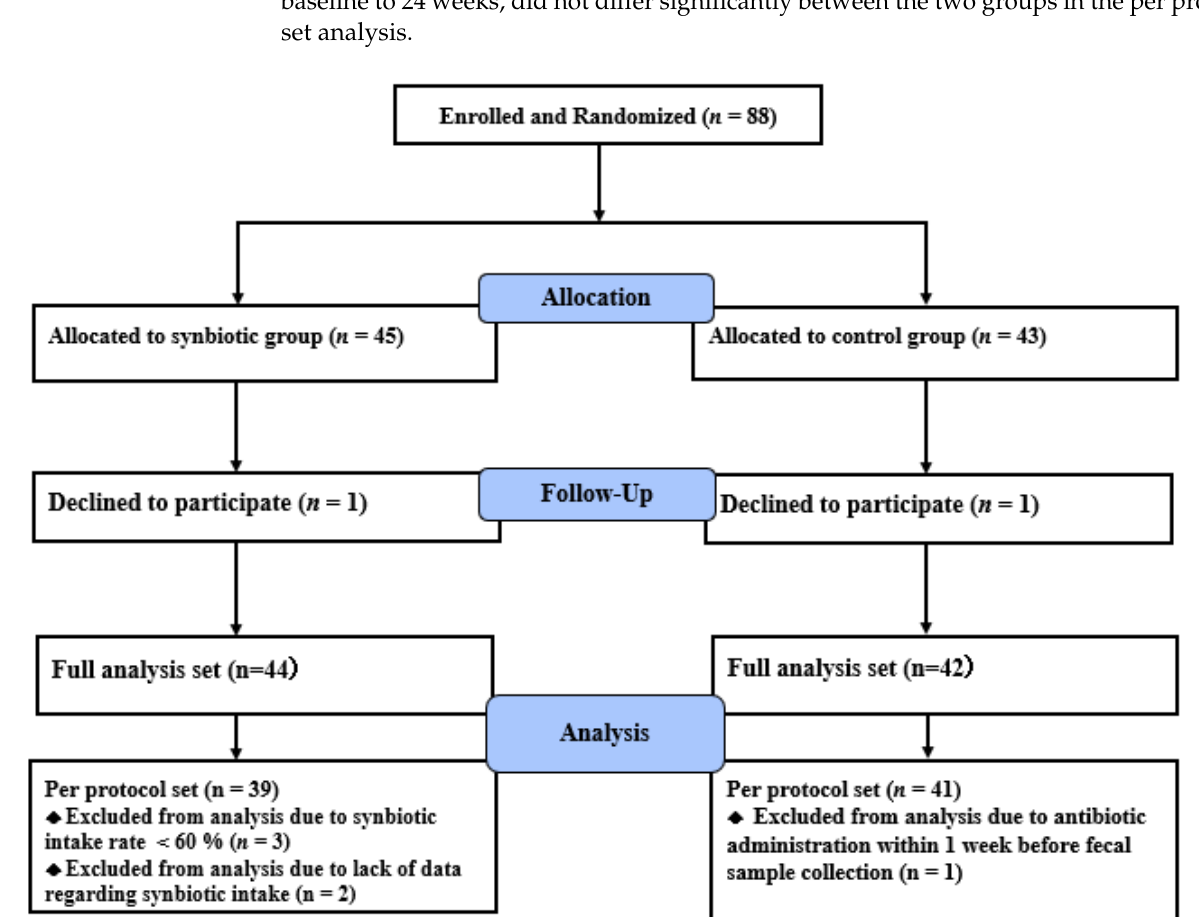
Figure 1. Flow diagram of patient recruitment. In total, 88 patients were randomly allocated to either the synbiotic group or control group. One patient each in the synbiotic and control groups declined to participate. The remaining 86 patients were followed up for 24 weeks. Table 1. Subject characteristics at baseline.